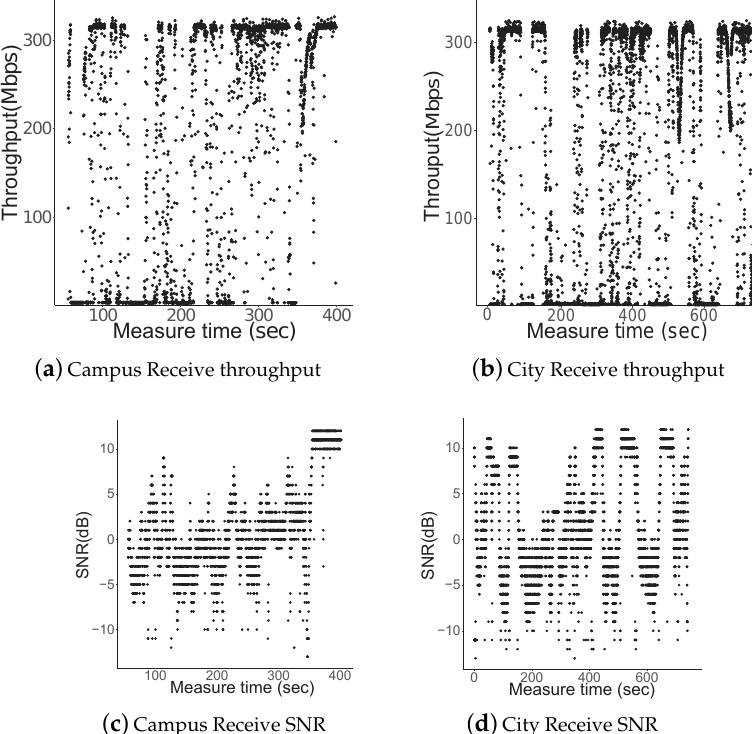
Figure 10. Campus and city road measurement